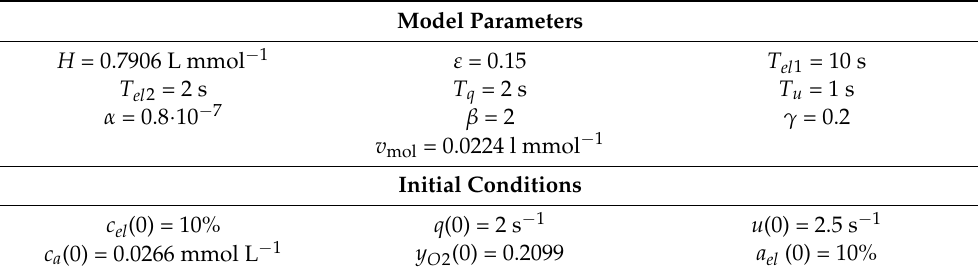
Table 1. DOC model parameter values and initial conditions of the state variables. Model